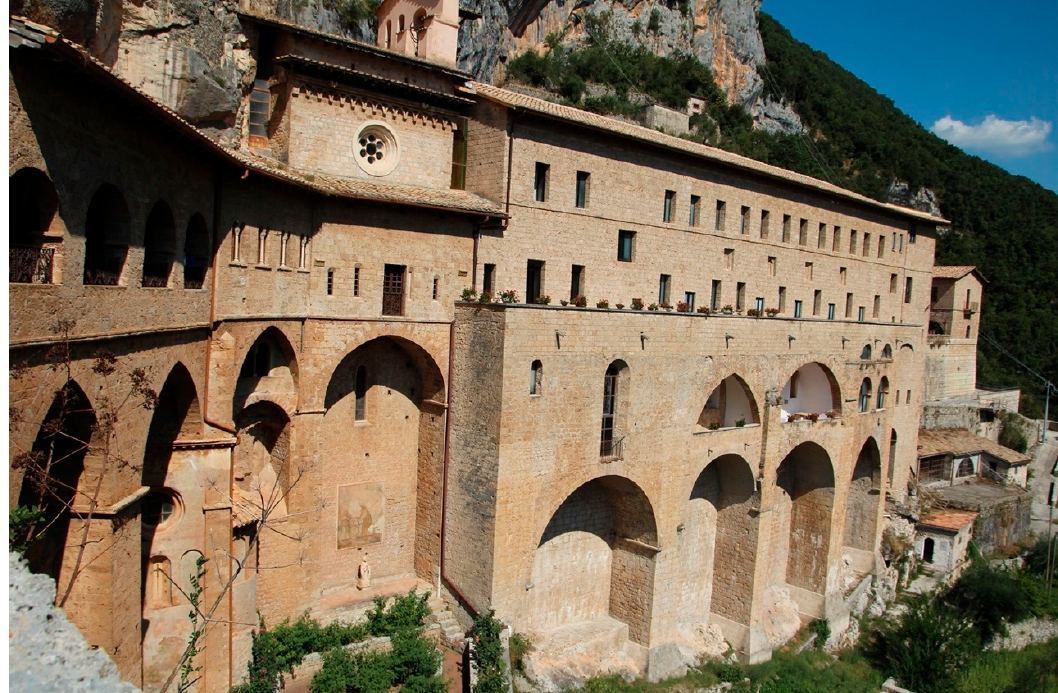
Figure 2. Sacro Speco, Subiaco (Italy). Exterior view. Photo: Roberta Cerone.